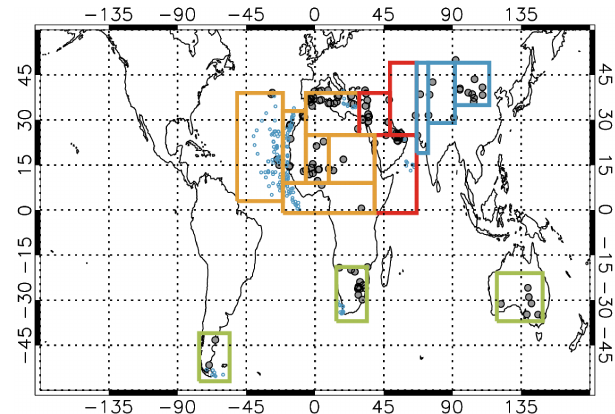
Figure 1. The 15 regions considered explicitly in this study are de- fined. Regions are grouped into African (orange), Middle Eastern (red), Asian (blue), and southern hemispheric (green). AERONET sites (gray circles) and Maritime Aerosol Network observations (blue dots) used to bias correct satellite AOD are indicated. The re- gions are identified as (1) mid-Atlantic, (2) northern Africa, (3) Gulf of Guinea, (4) west coast, (5) Mali/Niger, (6) Bodele Depression and Sudan region, (7) northern Middle East, (8) southern Mid- dle East, (9) Kyzyl Kum, (10) Thar, (11) Taklamakan, (12) Gobi, (13) South America, (14) South Africa, and (15)